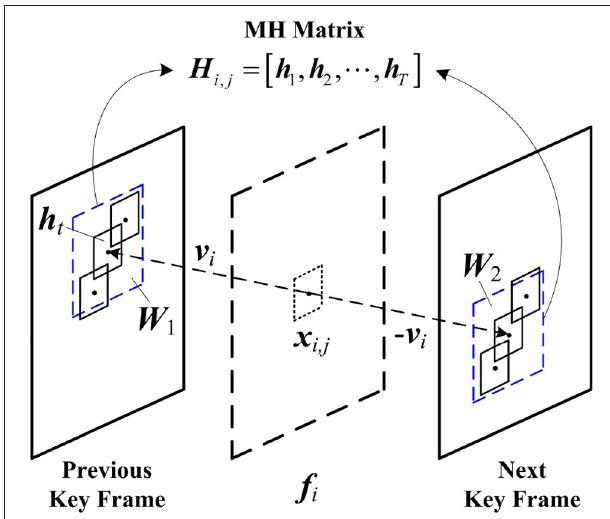
FIGURE 1 | Mechanism of Multi-Hypothesis (MH)